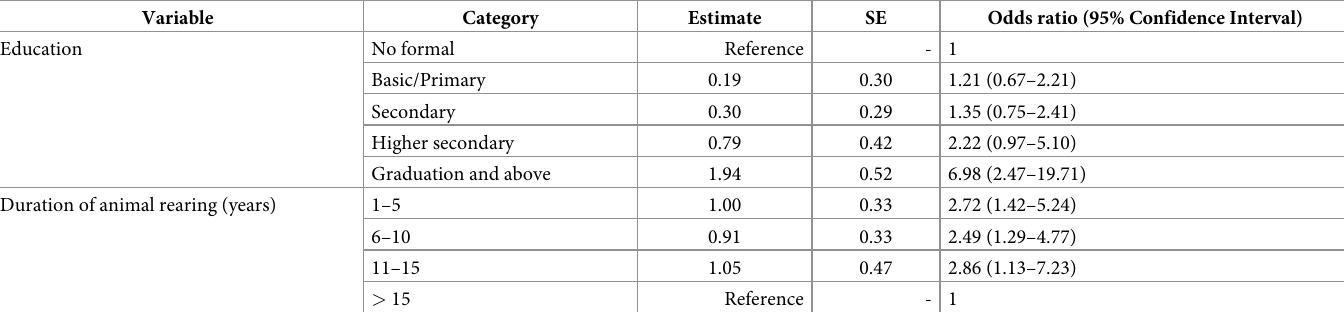
Table 7. Predictors of cattle handler’s overall practice with respect to zoonotic tuberculosis in the final multivariable logistic regression model. Variable